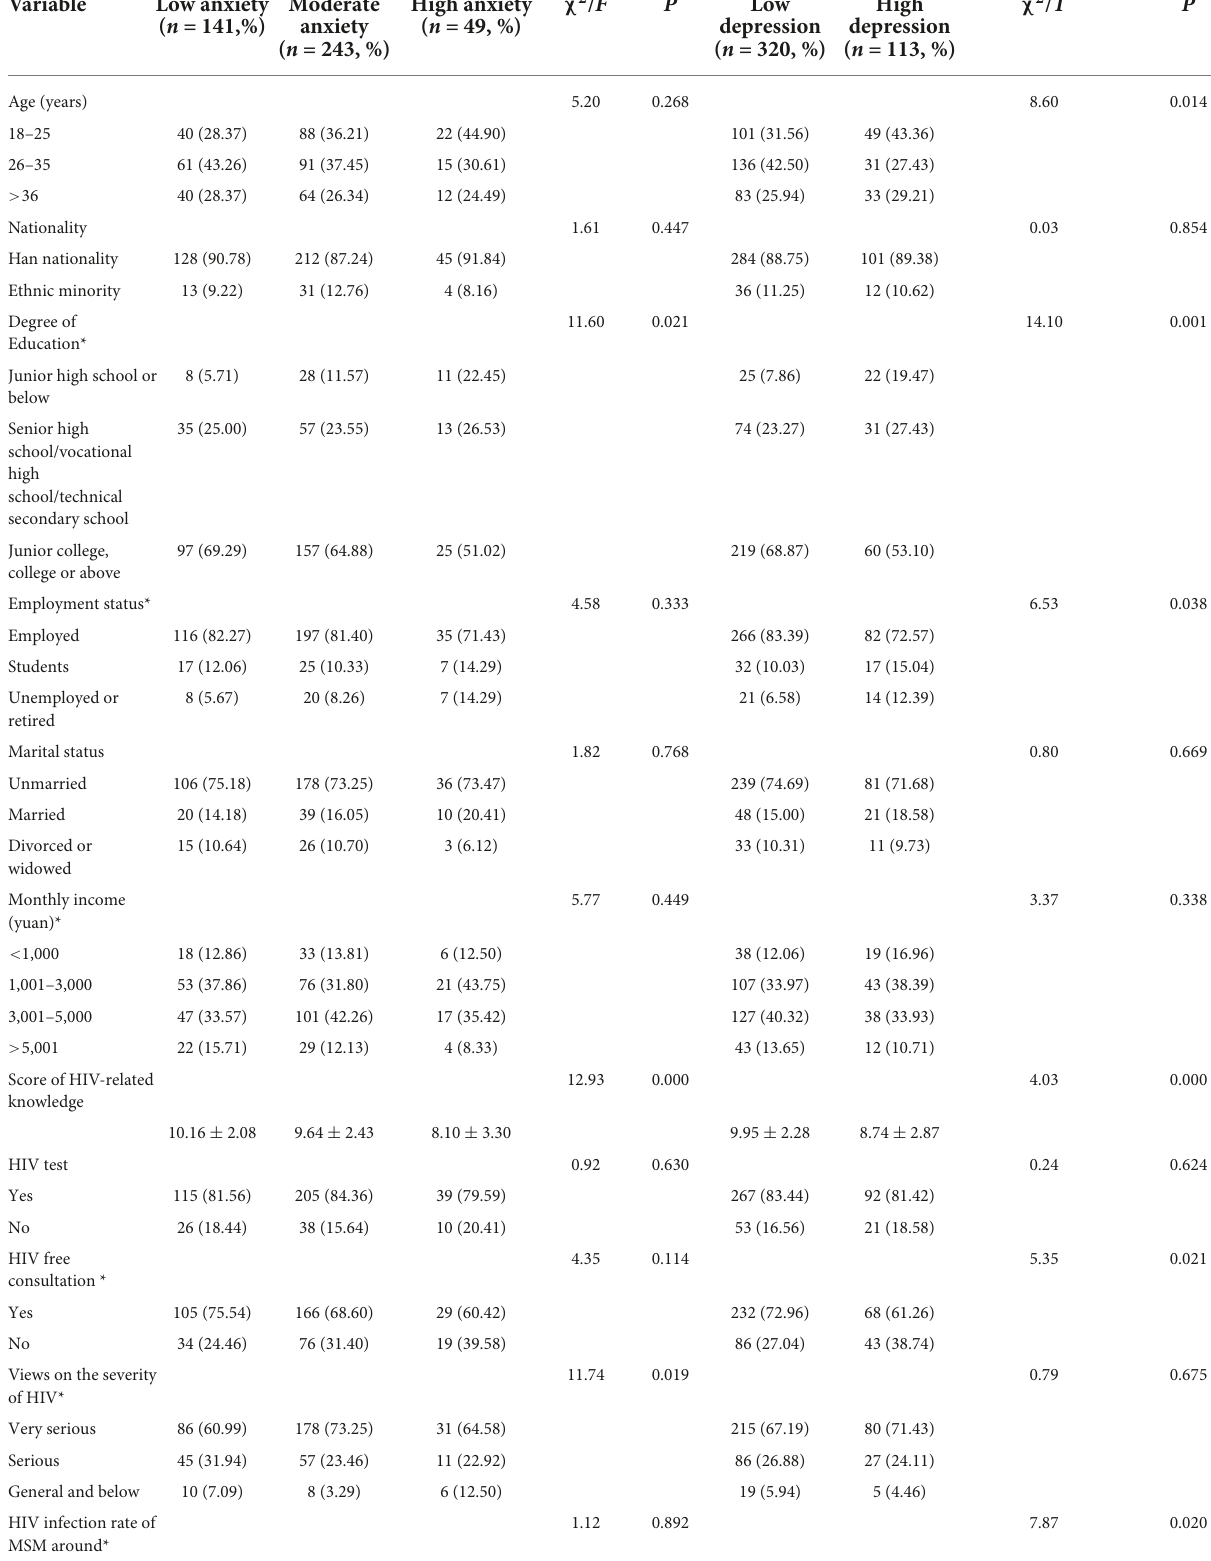
TABLE 5 A univariate analysis of anxiety and